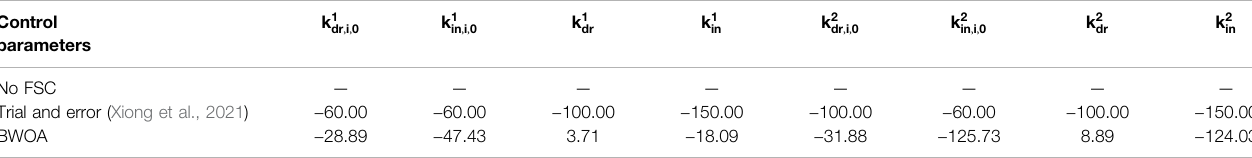
TABLE 3 | Optimal control parameters obtained by different methods under load increase 250 MW. Control parameters